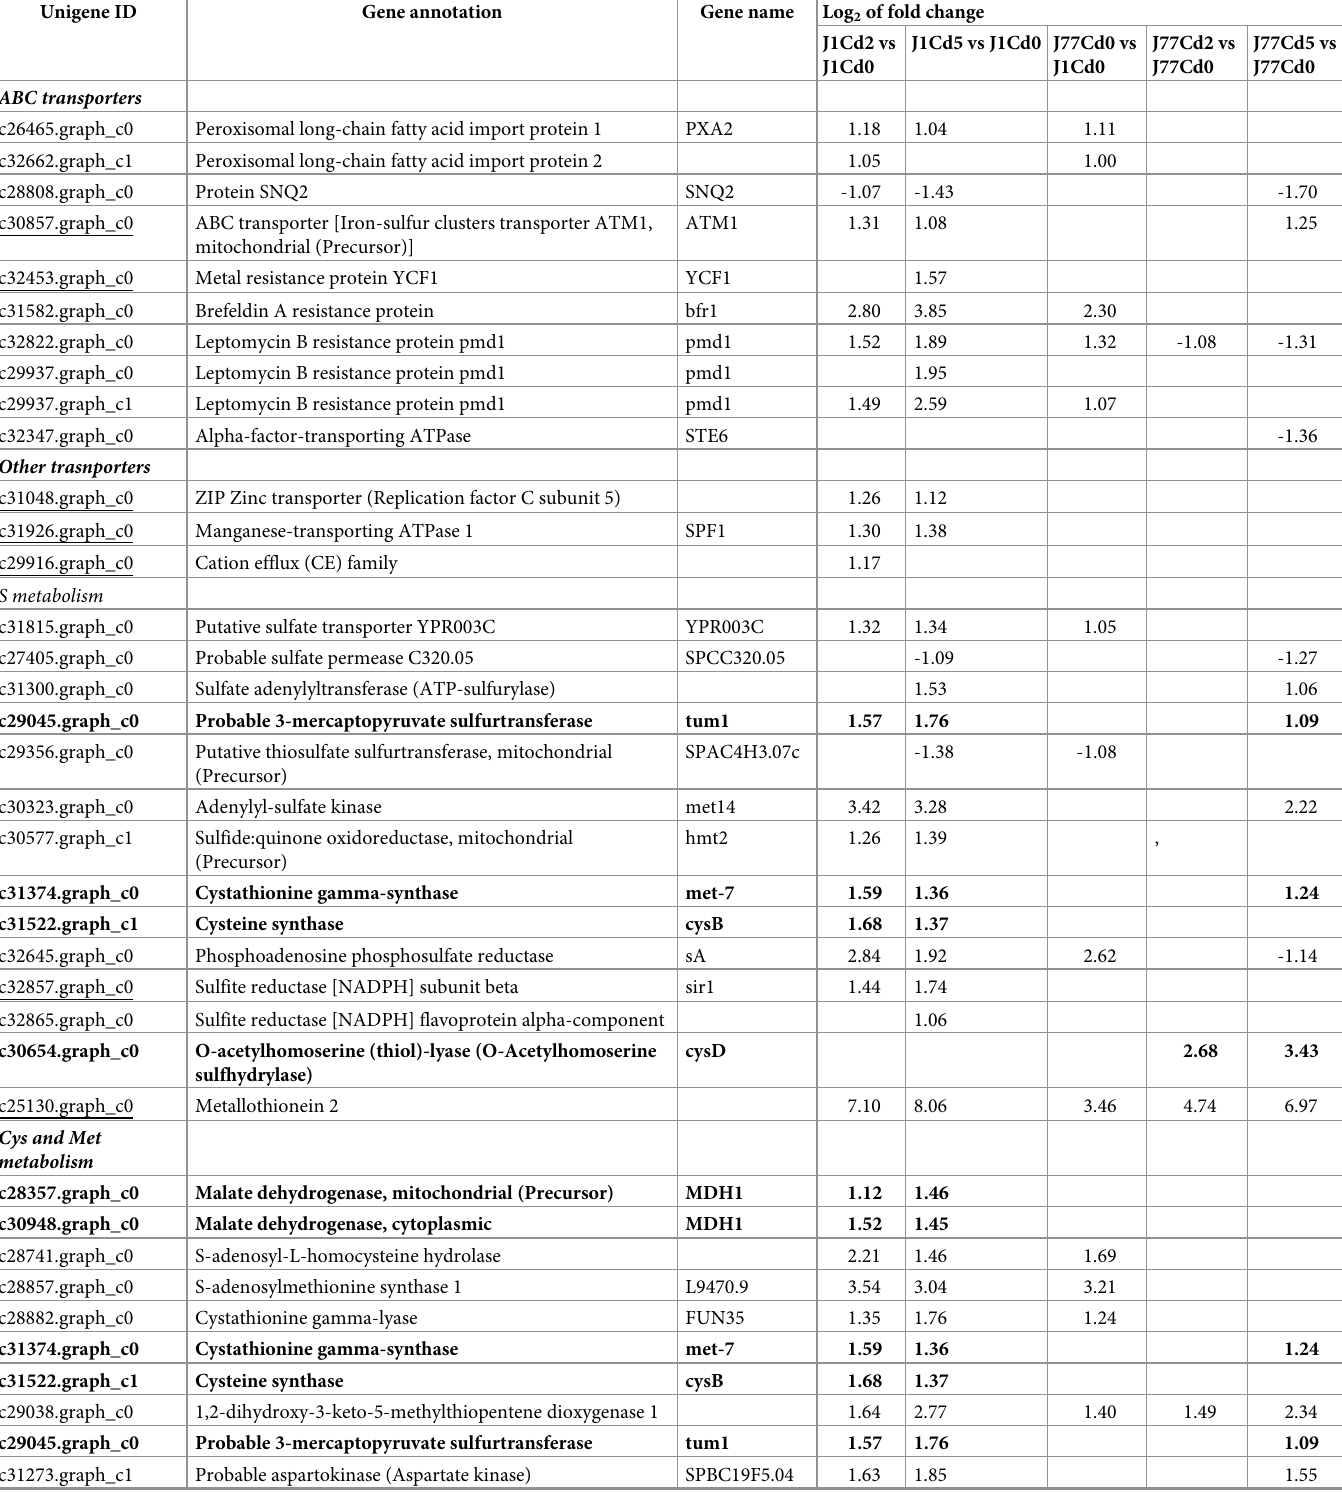
Table 1. List of DEGs possibly involved in Cd-accumulation and Cd-tolerance of J1 and J77 mycelia. Unigene ID Gene